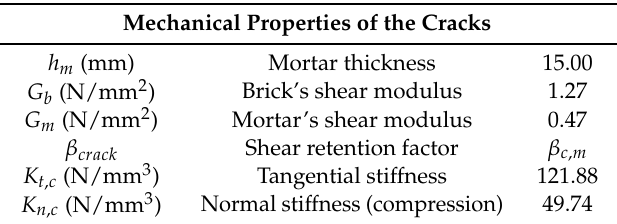
Figure 12. ( a ) Isometric view of the considered mesh model; ( b ) Discrepancies, expressed in mm, between the Non-Uniform Rational B-Splines (NURBs) and the photogrammetric models. Table 8. Mechanical properties considered for the interaction between macroblocks (cracks).